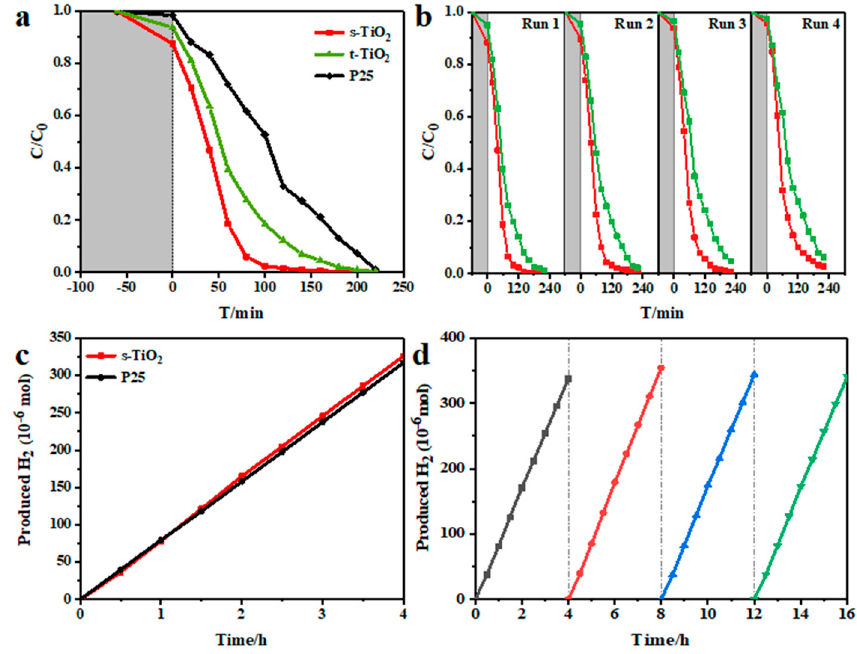
Figure 4. ( a ) Ultraviolet photocatalytic degradation performance, ( b ) photocatalytic degradation cycle stability test, ( c ) photocatalytic H 2 evolution rate, and ( d ) photocatalytic cycle hydrogen production performance of s-TiO 2 .